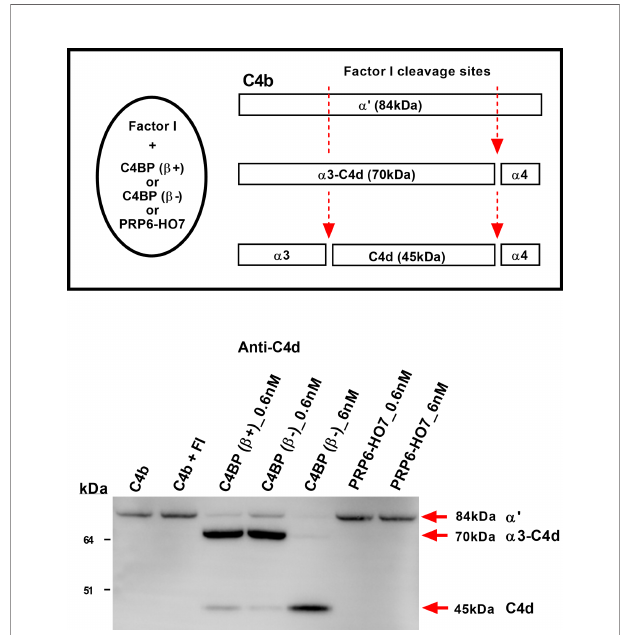
FIGURE 4 | PRP6-HO7 is devoid of complement inhibitory activity. Schematic drawing of C4BP( b +) and C4BP( b -) cofactor activity for factor I- mediated splitting of C4b. Factor I cleaves the a ′ -chain of C4b at two sites. Partial cleavage generates fragments a 3-C4d (70 kDa) and a 4 (14 kDa). Further cleavage of a 3-C4d yields the small C4d (45 kDa) fragment which remains associated with targets. C4BP( b +), C4BP( b -) and PRP6-HO7, at the indicated concentrations (lanes 3-7), were incubated with C4b (8.9 m g/ml) followed by addition of factor I (4.4 m g/ml). Reaction controls included C4b alone, and C4b + FI. All reactions were stopped after 30 min with SDS- reducing sample buffer. C4b cleavage fragments were separated by 4-12% SDS-PAGE under reducing conditions followed by Western blotting using an anti-C4d MoAb. Red arrows indicate the size of the C4b fragments. Cofactor activity was con fi rmed by the appearance of a 3-C4d (70 kDa) or C4d (45 kDa). Results are representative of 3 independent